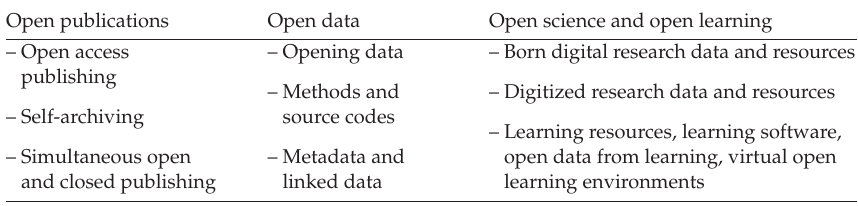
Table 1: The multifaceted operational environment of open science for the UEF